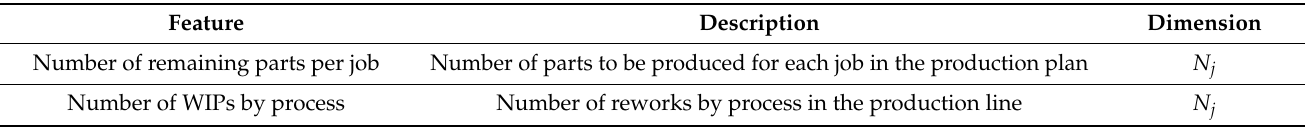
Table 1. Components of state.